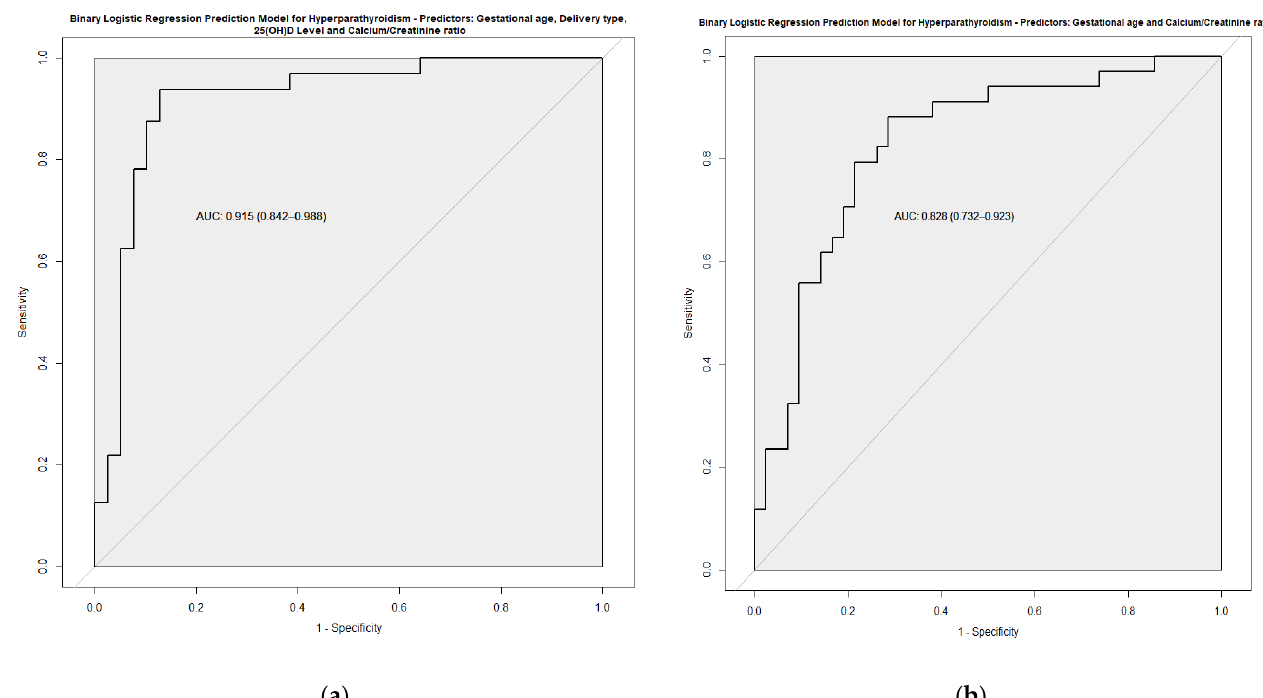
Figure 3. ROC curve of two prediction models developed based on multivariate analysis: ( a ) Model 1; ( b ) Model 2.